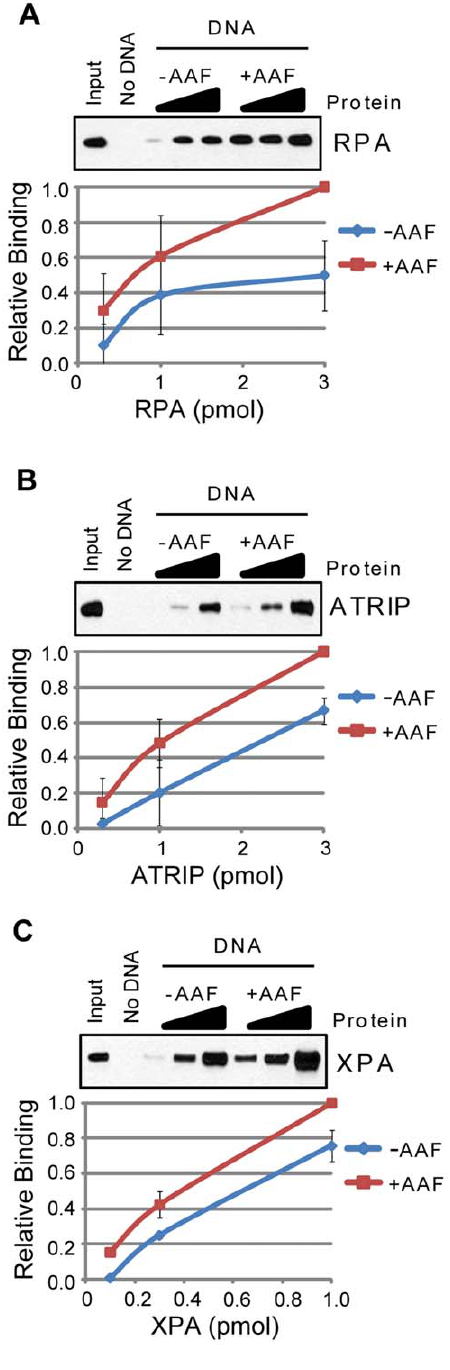
Figure 7. RPA, ATRIP, and XPA show a slight preference for AAF-damaged DNA. The association of each of the indicated purified proteins with beads alone (No DNA) or to undamaged ( 2 AAF) or N - acetoxy-2-acetylaminofluorene (AAF)-treated ( + AAF) plasmid DNA bound to magnetic beads was analyzed by SDS-PAGE and immuno- blotting. Each of the following proteins was analyzed for binding to each DNA structure: (A) RPA, (B) ATRIP, and (C) XPA. Reactions were carried out as described in the Methods section.